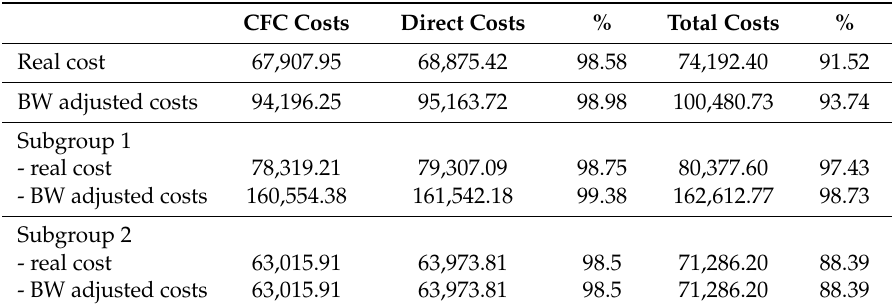
Table 8. Real and BW-adjusted costs of medication / patient / year and their proportion from direct and total costs (EUR).